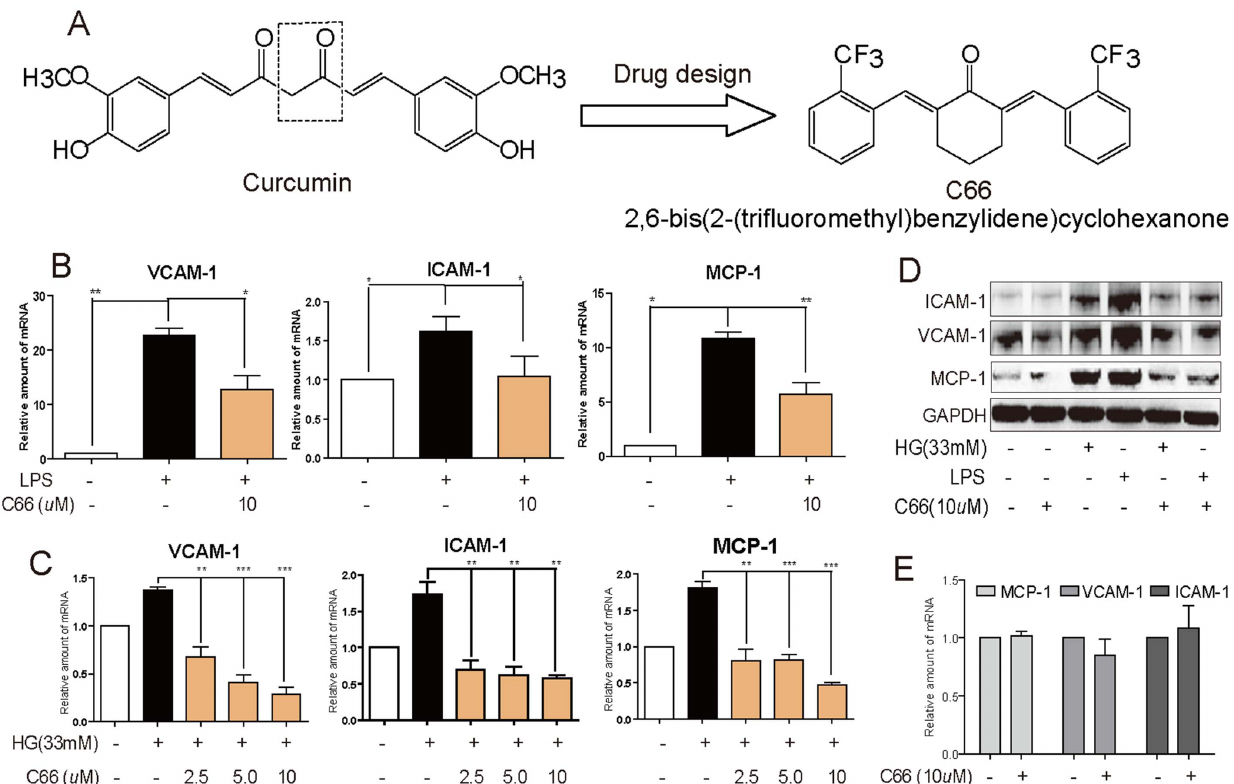
Figure 1. C66 inhibited LPS- and HG-induced mRNA expression of adhesion molecules and chemokines in NRK-52E cells. A) Chemical structures of curcumin and C66. B) and C). NRK-52E cells (2.5 6 10 6 ) were pretreated with C66 at various concentrations (2.5, 5, or10 m M) or DMSO for 2 h, then stimulated with 0.5 m g/mL LPS (B) for 8 h or 33 mM HG (C) for 24 h. Total RNA extraction was performed as described in Materials and Methods. The mRNA levels are expressed as a ratio of b -actin and normalized to controls. D) Cells (2.5 6 10 6 ) were pretreated with C66 at 10 m M or DMSO for 2 h, and then stimulated with 0.5 m g/mL LPS for 12 h or 33 mM HG for 24 h. Total protein extraction was analyzed via western blot. E) Cells were treated with C66 at 10 m M or DMSO for 24 h, and total RNA was extracted for RT-qPCR analysis. Bars represent the mean 6 SD of four independent experiments in triplicate (* p , 0.05, ** p , 0.01, *** p , 0.001).